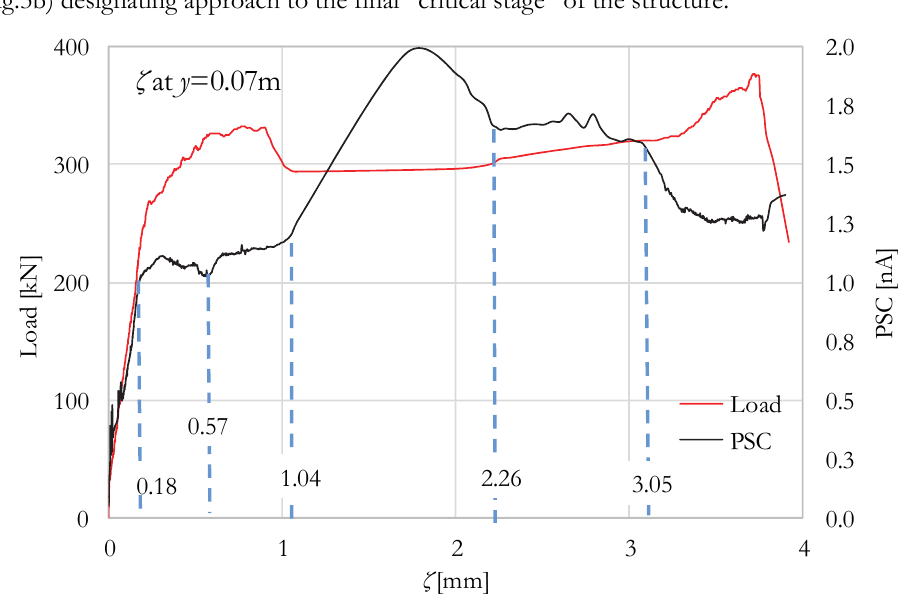
Figure 7: The variation of the load and the PSC versus the opening, ζ , of the